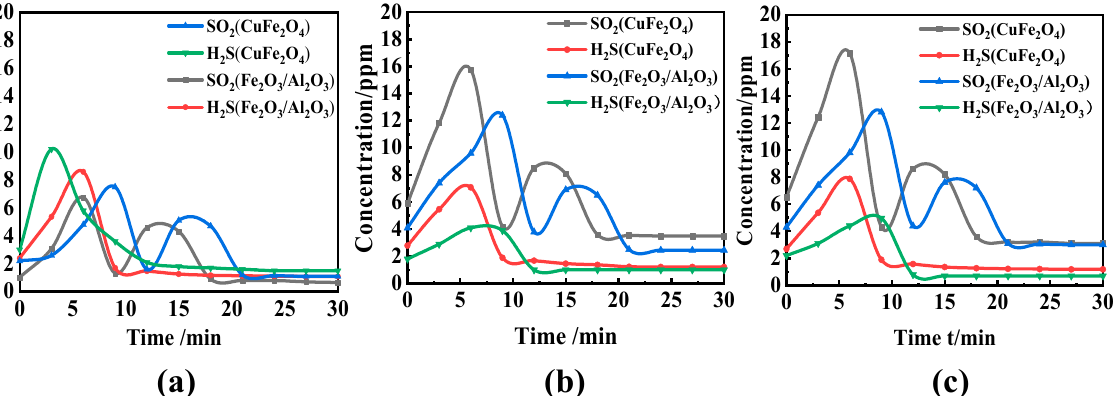
Figure 8. The variation trend of H 2 S and SO 2 with time in the process of CLC at ( a ) O/C=1, ( b ) O/C=3 and ( c ) O/C=5 in 850 °C.